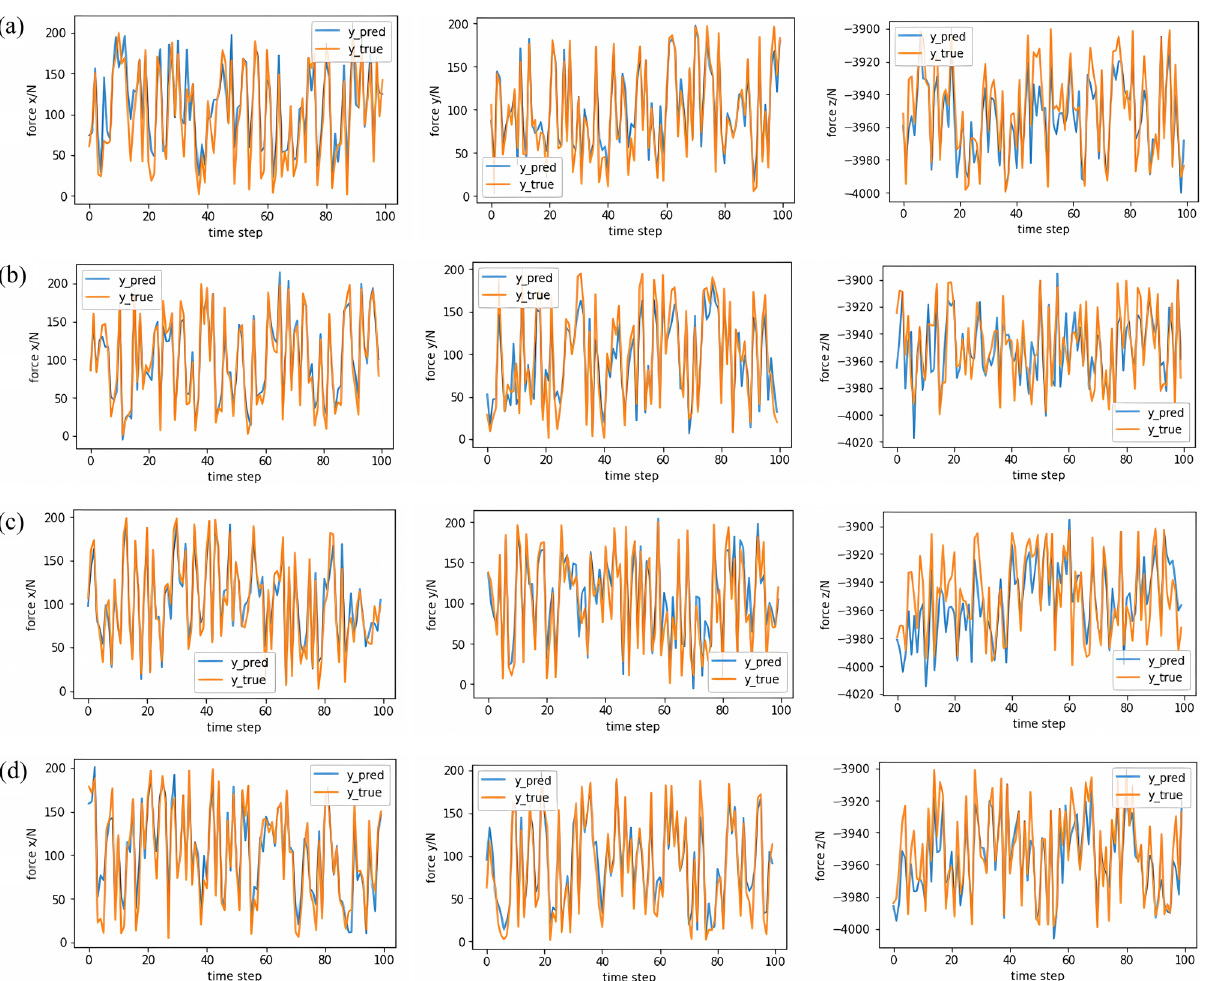
Figure 12. The prediction results of the proposed model under cross-validation schemes 1 ( a )–4 ( d